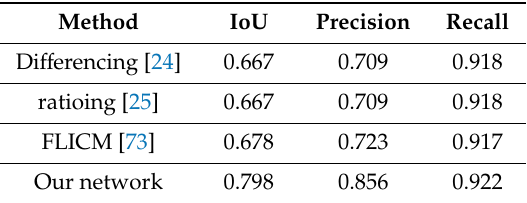
Table 5. Di ff erent methods to discover changed buildings at the pixel level from the bi-temporal building classification map produced by the Mask R-CNN. “Our network” is the change detection network trained with simulated